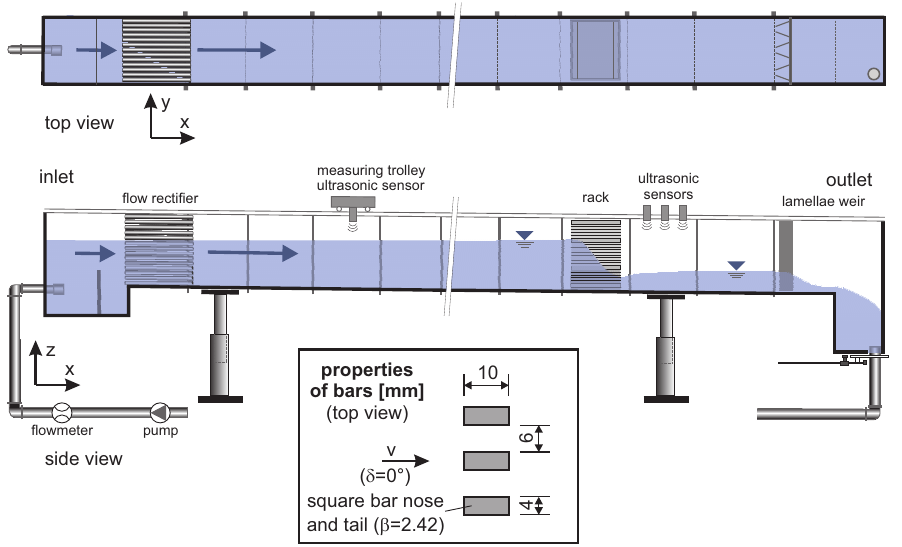
Figure 1. The experimental setup consists of a rectangular channel with glass walls and an installed rack. The water is pumped in from a reservoir and passed an electromagnetic flowmeter before entering the channel. A lamellae weir controls the water level downstream of the rack. We installed a 1.28 m long rack in the channel, beginning at x = 21.25 m. The rack has the following properties: clear distance between the bars e = 6 mm, bar thickness s = 4 mm, bar depth d = 10 mm, bar shape coefficient β = 2.42 (square nose and tail), blockage ratio as the ratio of the area blocked by the bars to the gross area of the trash rack p = 0.4. In the experiment, the inclination of the bars from the horizontal (inclination of the rack) remained at α = 90 ◦ , while the angle of oblique approaching flow was consistent δ = 0 ◦ . Behind the rack, beginning at x = 27.83 m, rotatable vertical blades mounted in the channel served as a lamellae weir. Rotating the blades lets the channel width